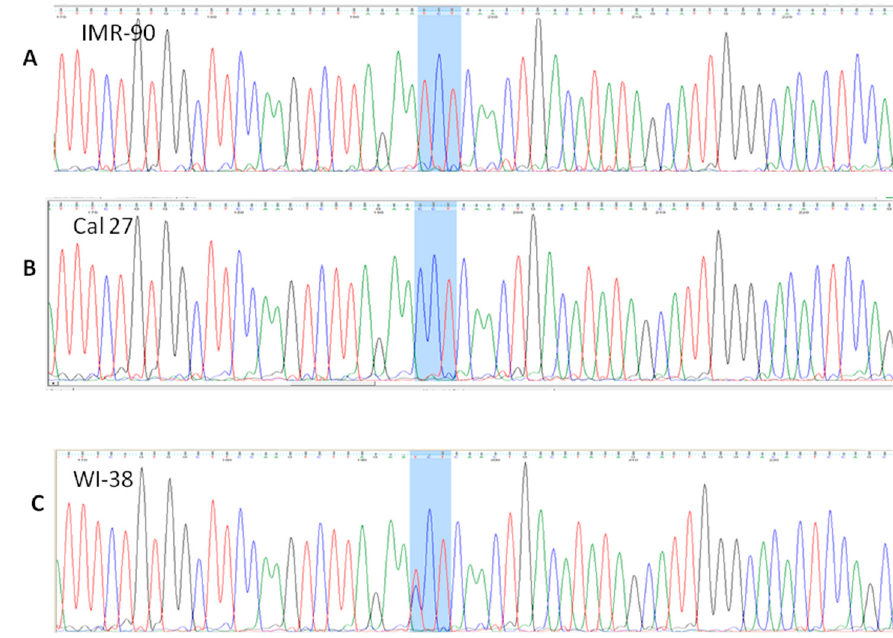
Figure 9. The presence of SNV rs1800566, in IMR-90 (NQO1*2/*2; ( A )) and WI-38 (NQO1*1/*2; ( C )). The homozygous triplet TCT, coding for Serine, replaces the CCT triplet coding for Proline, which was present in all cancer cell lines, as shown for Cal 27 ( B ).